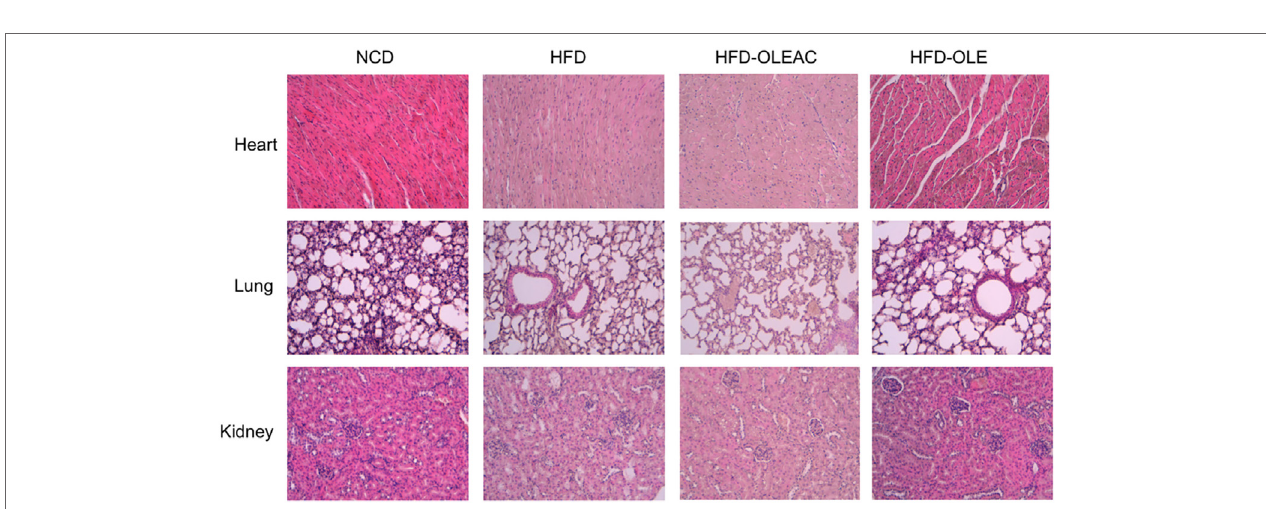
FigUre 5 | Histologic examination of heart, lung, and kidney sections. No appreciable histological differences were detected at these levels, among the four groups of mice, at the end of the 5 weeks treatment period with either oleacein (HFD-OLEAC) or oleuropein